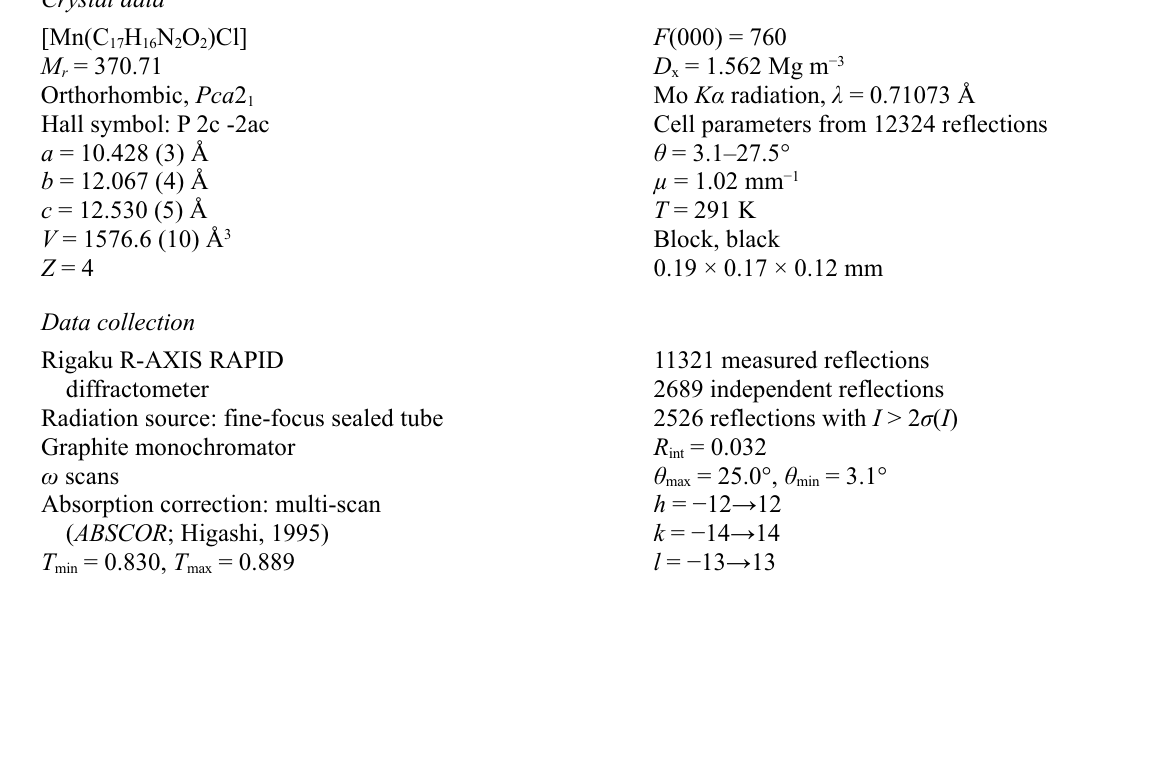
Figure 1 The molecular structure of (I), showing 30% probability displacement ellipsoids. Chlorido{2,2 ′ -[propane-1,3-diylbis(nitrilomethylidyne)]diphenolato- κ 4 O , N , N ′ , O ′ }manganese(III) Crystal